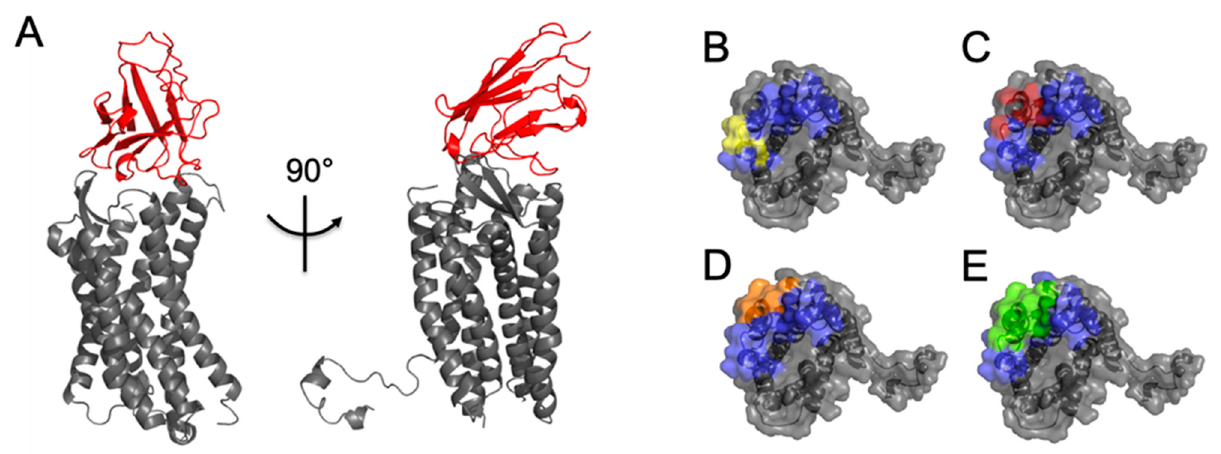
Figure A3. Epitopes of 238D2, 3SM5, and 4N1H on CXCR4. ( A ) Model of 238D2 3D structure docked on the CXCR4 according to MAbTope method. B to E. Top view of CXCR4 extracellular part ( gray ) where the ECL2 is shown in blue. ( B ) In yellow are represented 238D2 epitope residues experimentally determined by Jähnichen and coll. [15]. ( C – E ) Core epitopes as predicted by MAbTope for 238D2